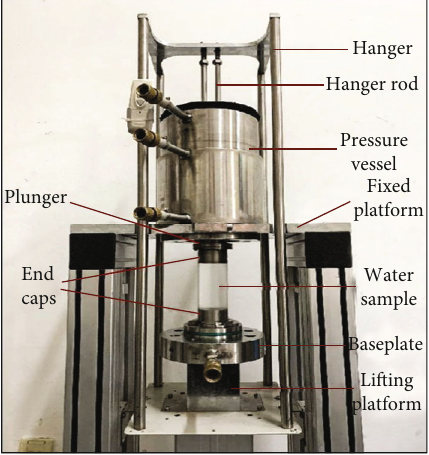
Figure 4: Mounting device.